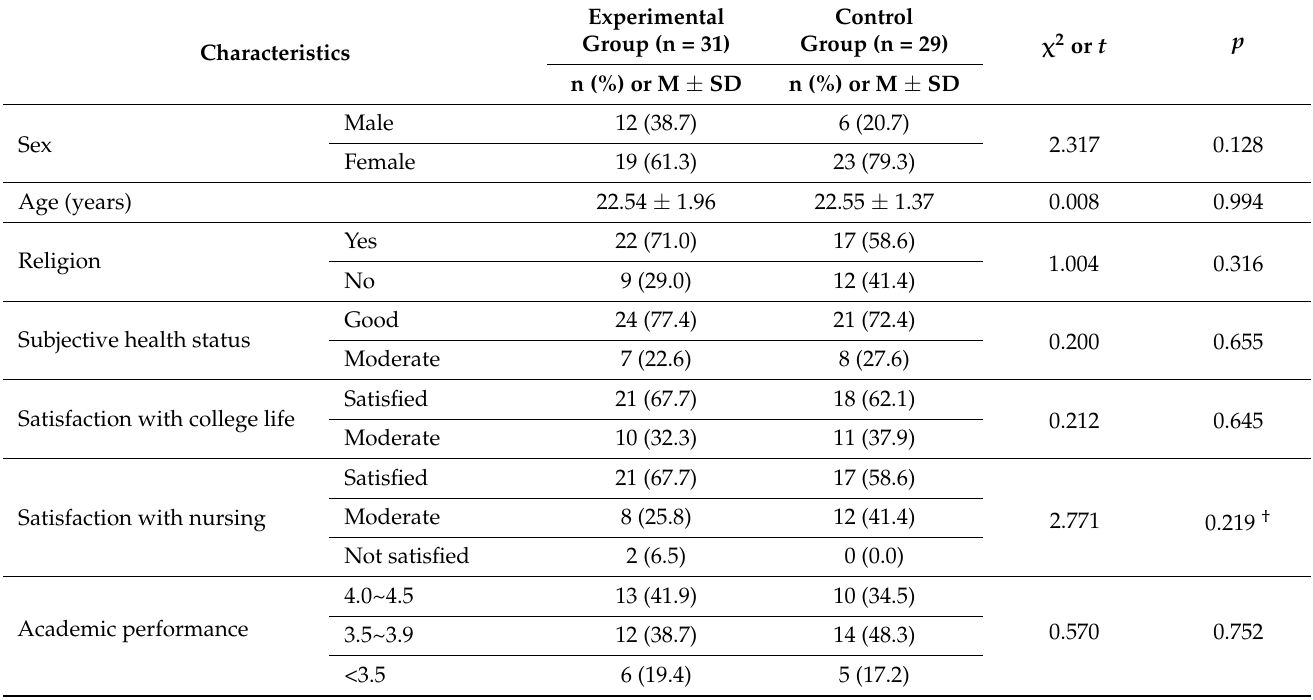
Table 2. Homogeneity of general characteristics of participants between groups before intervention (n = 60).